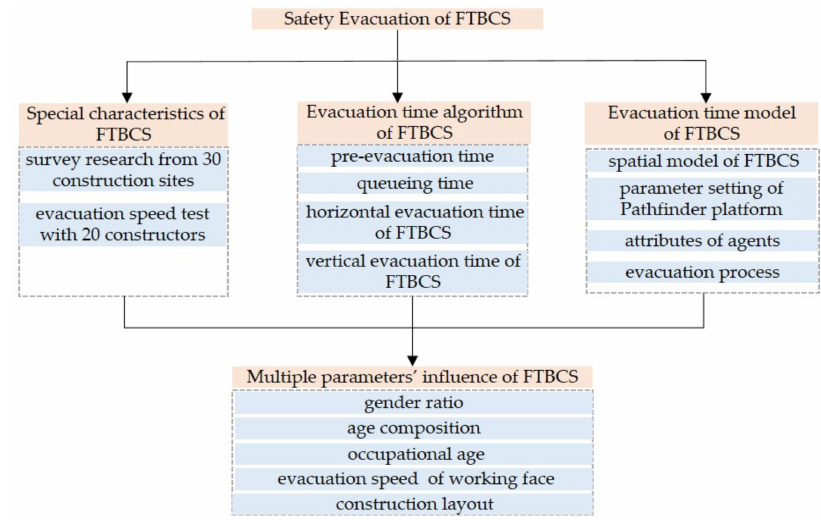
Figure 2. Methodology diagram.